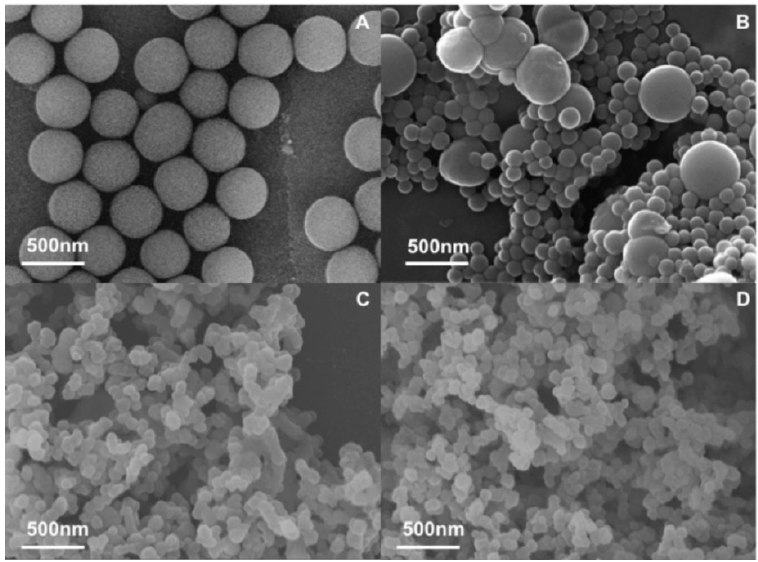
Figure 1. SEM micrographs of ( A ) SiO 2 _p and ( B ) SiO 2 _c nanoparticles and ( C ) SiO 2 /HA_p and ( D ) SiO 2 /HA_c hybrid